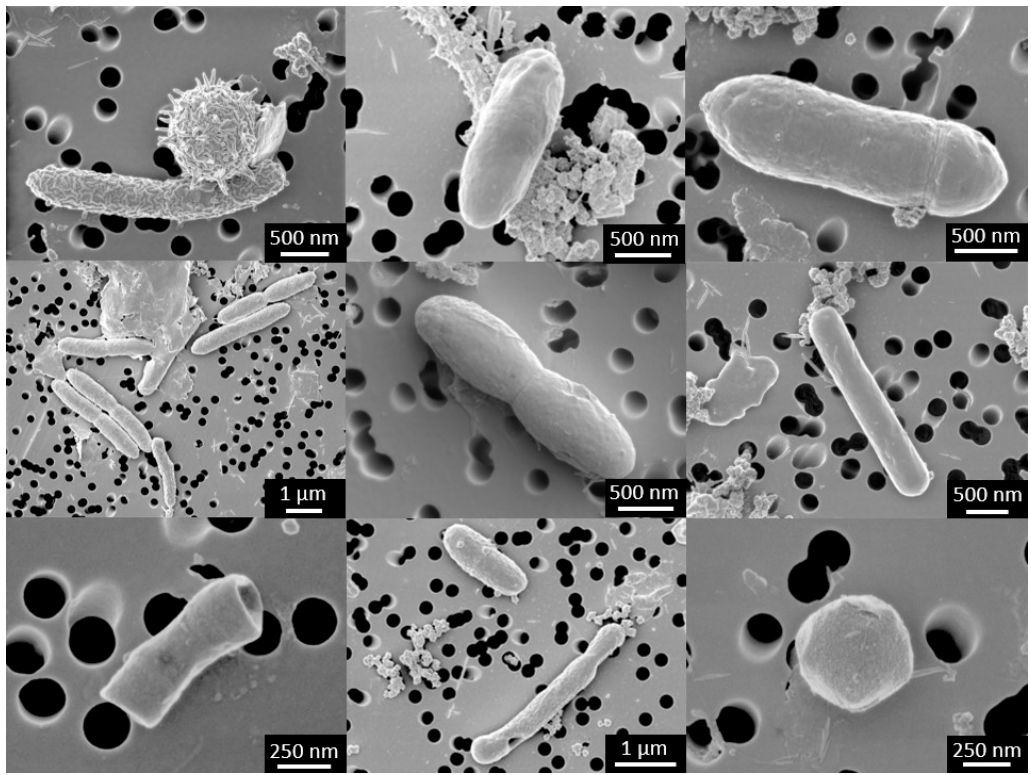
Figure 2. Examples of microbial morphotypes: rods and cocci found in well TVR-B captured by SEM. Inorganic nanoparticles which form conglomerates can be seen.